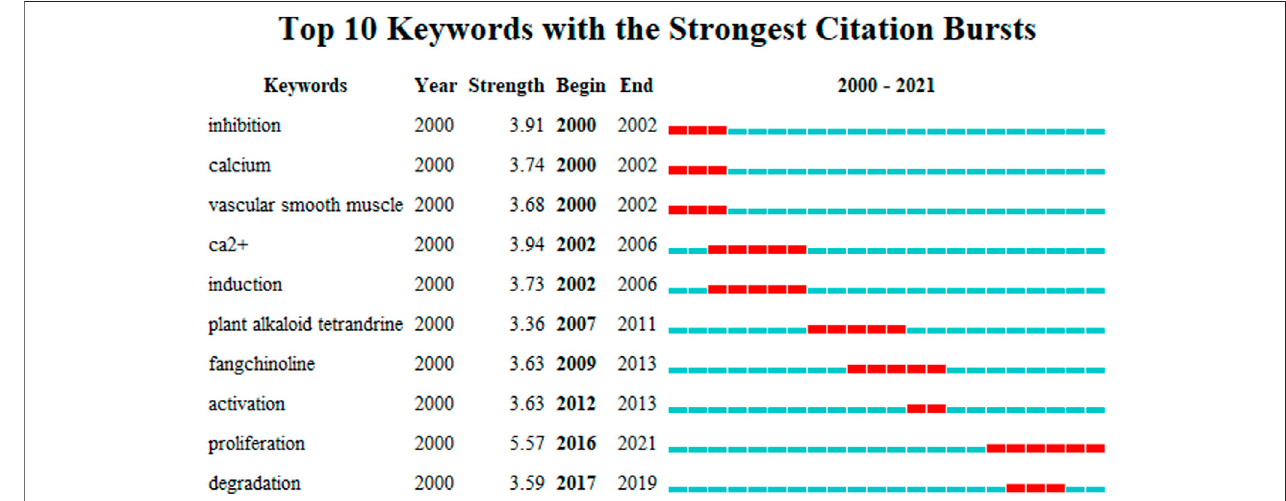
FIGURE 7 | Top 10 keywords with the strongest citation